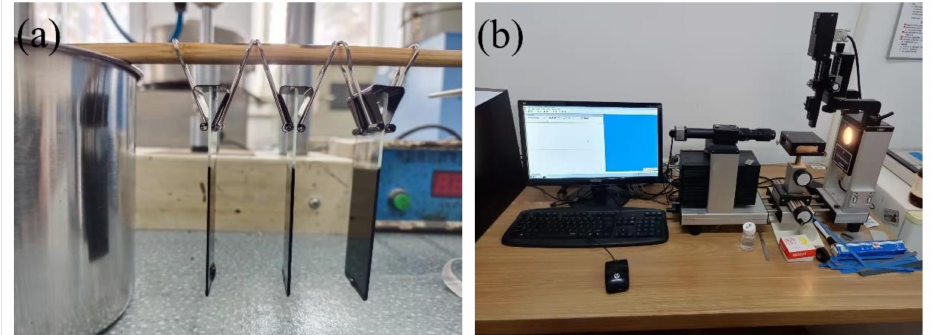
Figure 24. Contact angle test: ( a ) Bitumen film sample; ( b ) OCA 20 video optical contact angle measuring instrument.